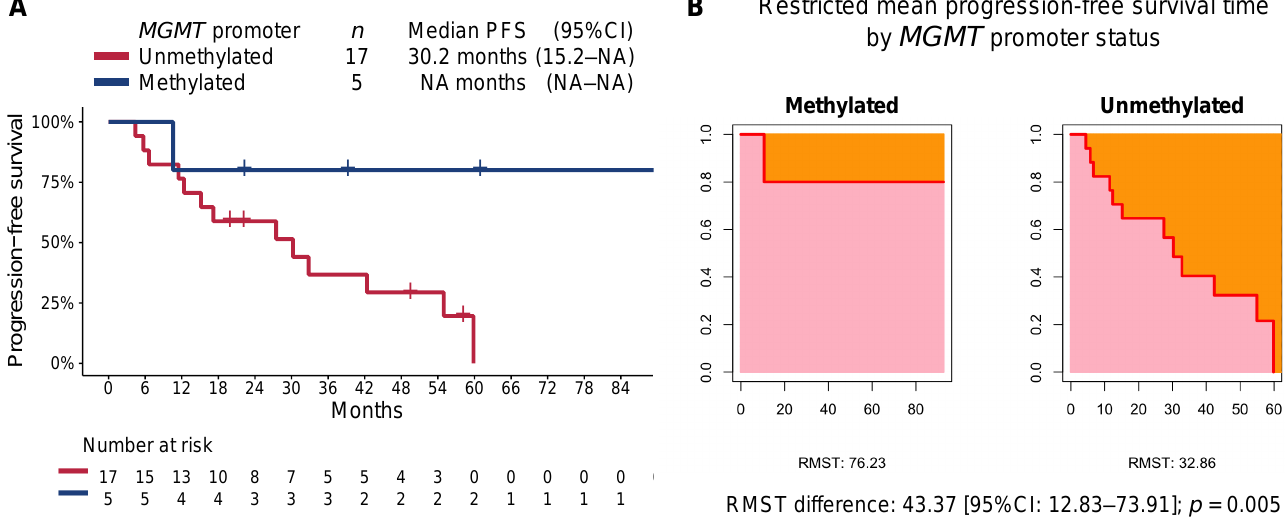
Figure 2. ( A ) Kaplan–Meier estimate of progression-free survival (PFS) by MGMT-promoter methy- lation status, and ( B ) restricted mean progression-free survival time (RMST) by MGMT-promoter methylation status.